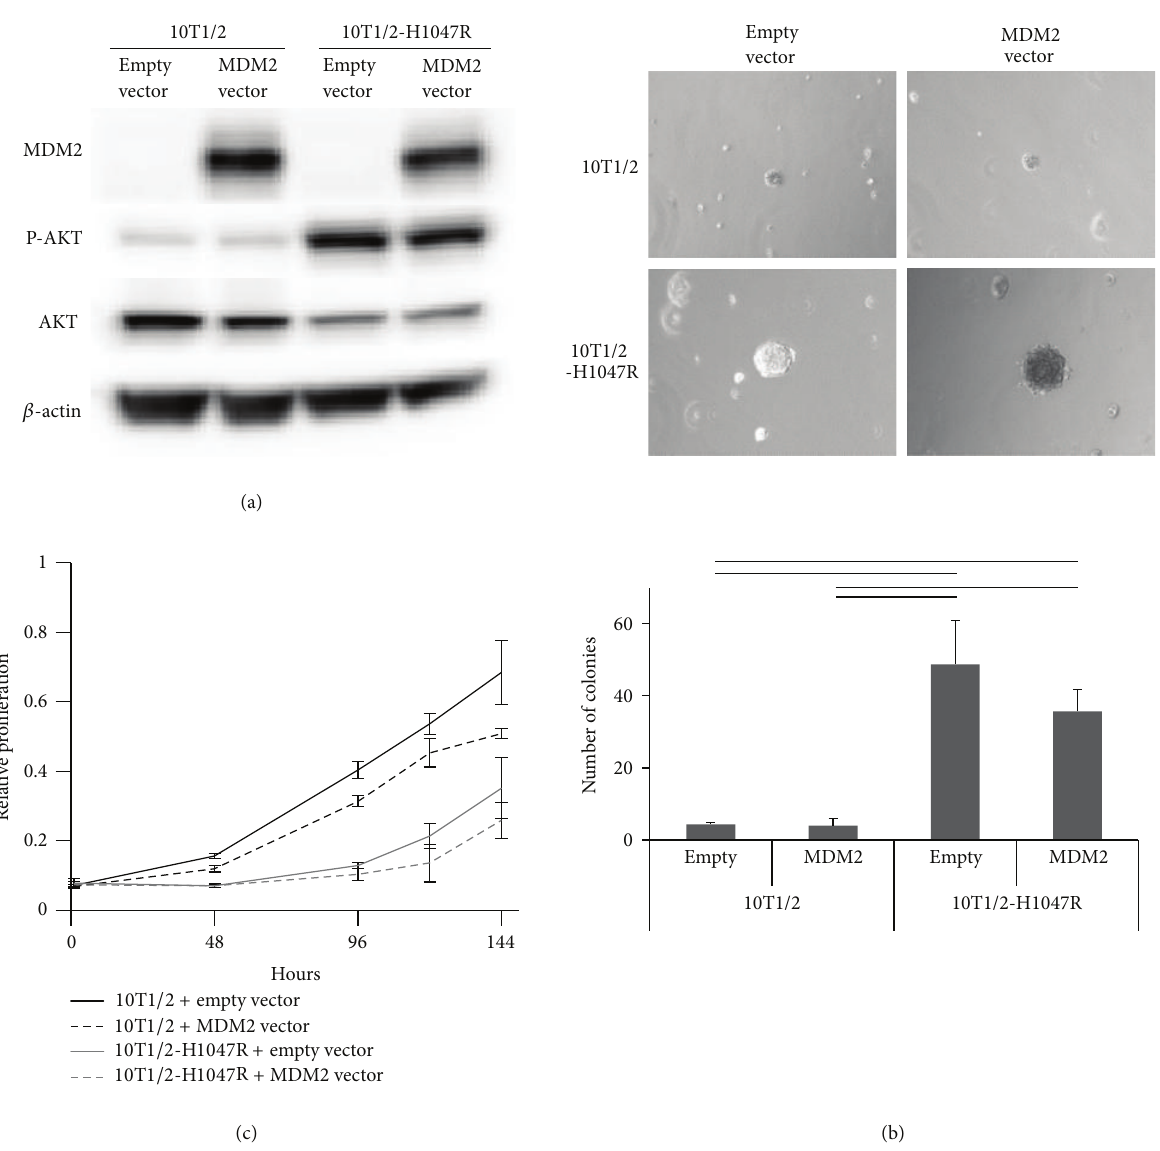
Figure 3: (a) Western blotting of MDM2, Akt, phosphoAkt, and 𝛽 -actin. Total cell lysates were isolated 48 h after transfection. (b) Soft-agar colony formation assay (means ± SD, 𝑛 = 3 ). Black line shows significant difference ( 𝑃 < 0.05 ). (c) Relative proliferation rates of 10T1/2 cells and 10T1/2-H1047R cells transfected with MDM2 vector or empty vector, as measured by MTS assay (means ± SD, 𝑛 = 3 ).